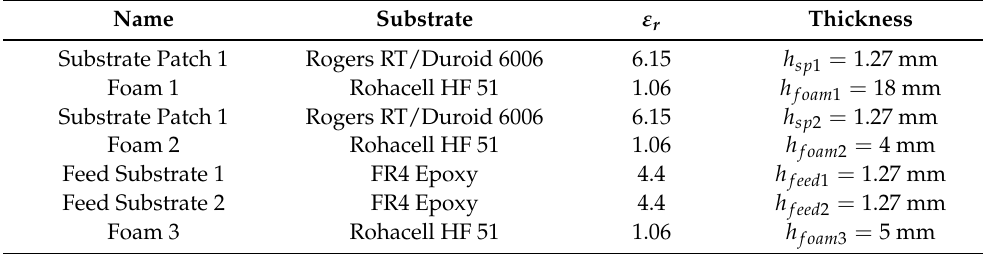
Table 1. Antenna layer properties.